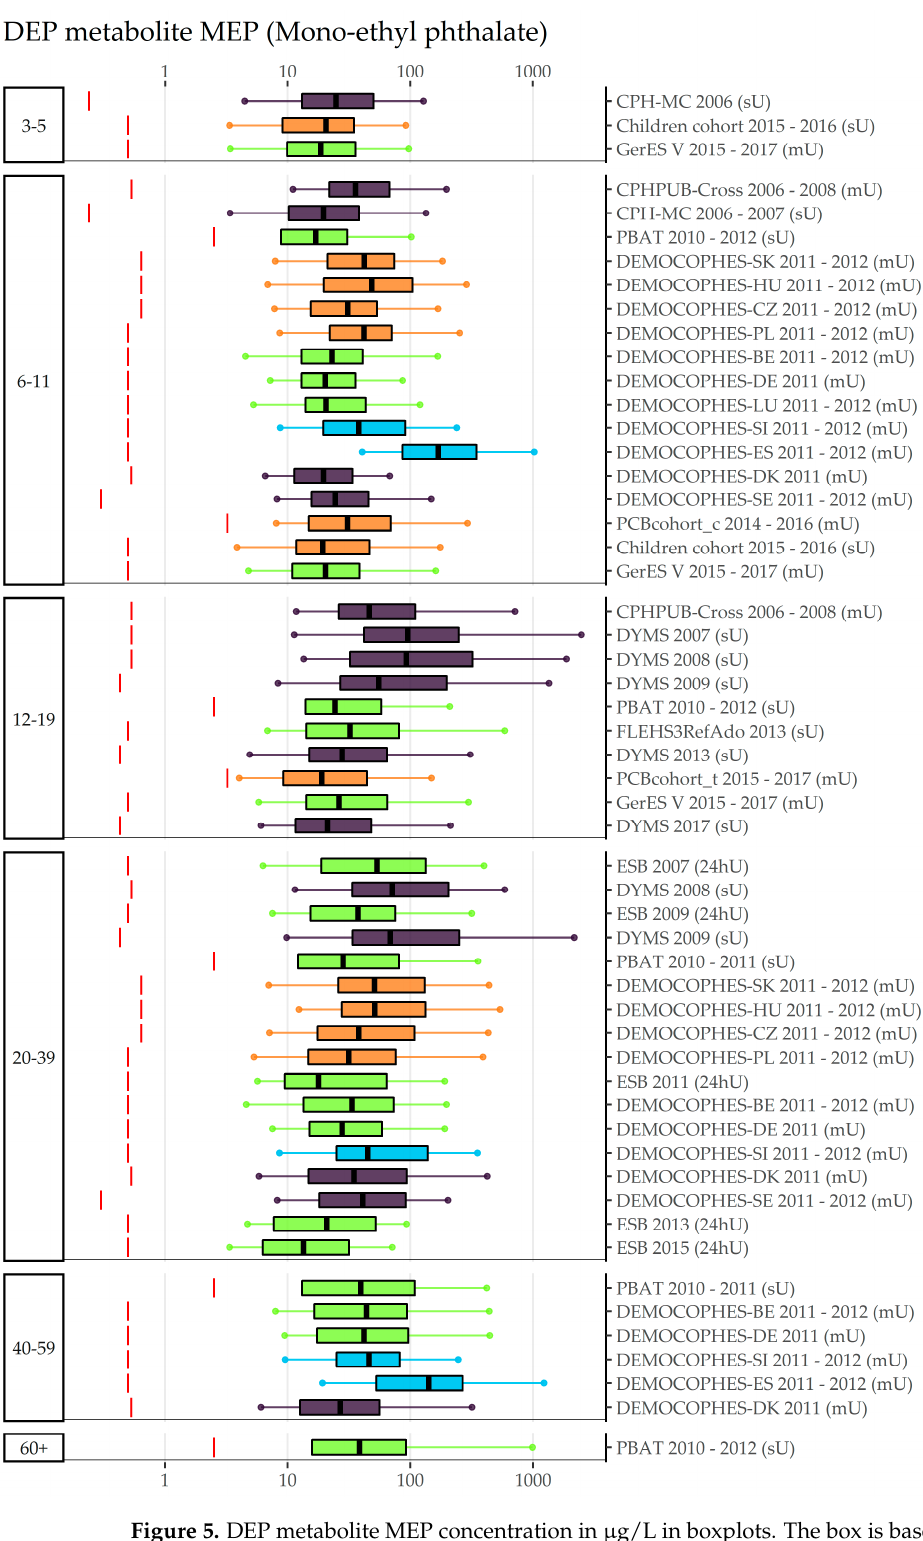
Figure 5. DEP metabolite MEP concentration in µ g/L in boxplots. The box is based on P25, P50, and 5 P75, and the whiskers are based on P5 and P95. Boxplots are presented separately by age groups; within age groups they are chronologically sorted by year of sampling. Colors of the boxplots refer to the data collection’s region (North = violet, South = blue, West = green, East = orange, Israel = dark red). Red lines denote LOQ/LOD for the respective study. Since percentiles are only available and displayed when they are above LOQ/LOD, the lower side of the boxplots might be